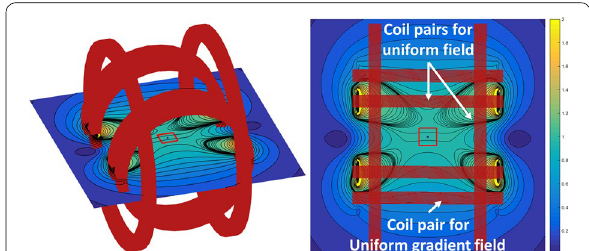
Figure 9 Schematic of the EMA system